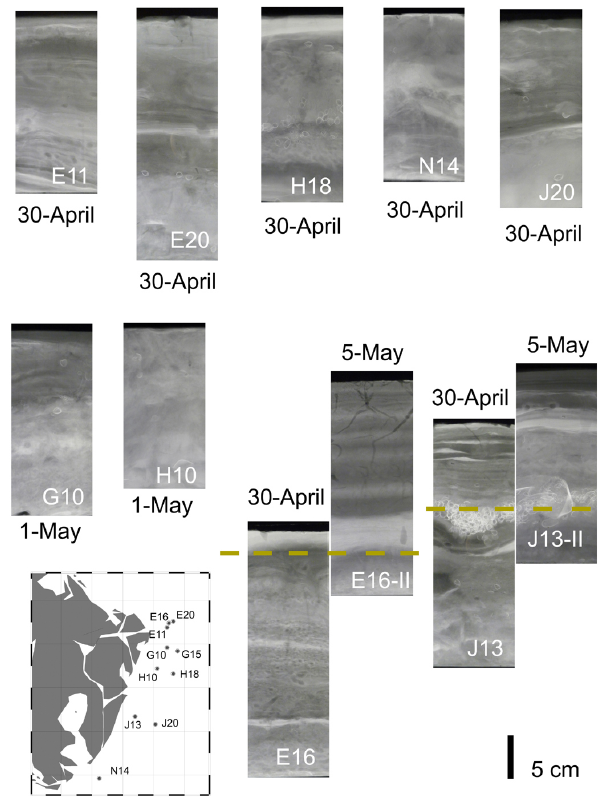
Fig. 6. Radiographs of sediment cores collected in Po prodelta in 30 April, 1 May, and 5